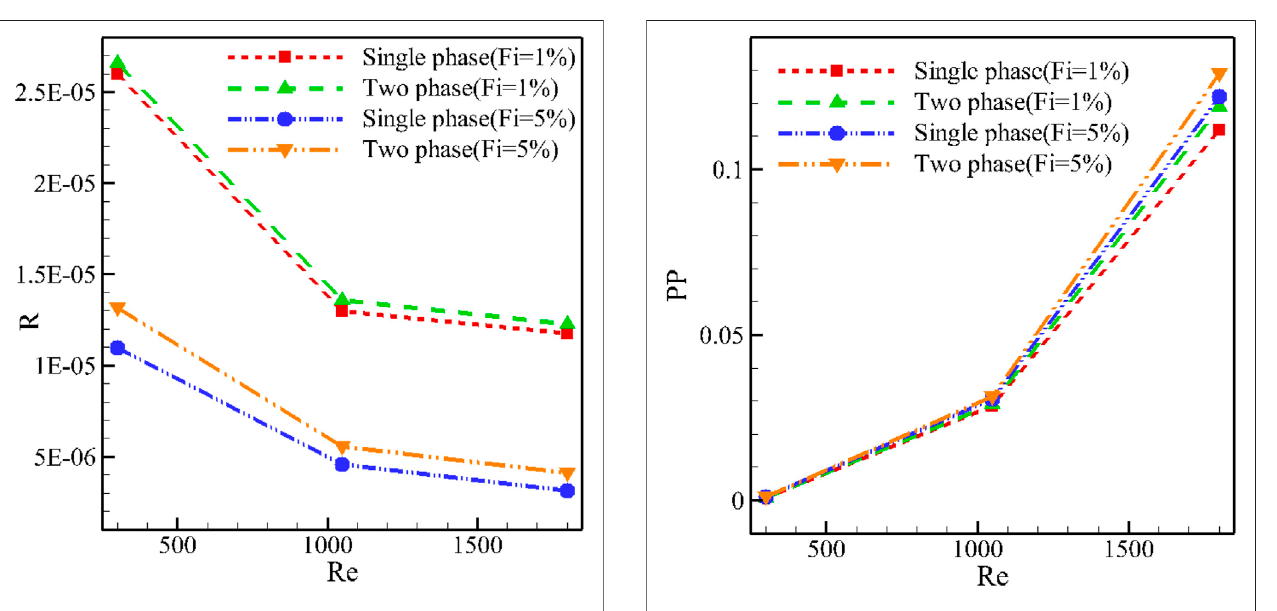
FIGURE9| PPatdifferentvaluesofRewhen φ (cid:1) 2%fortheT-PandS-P simulation